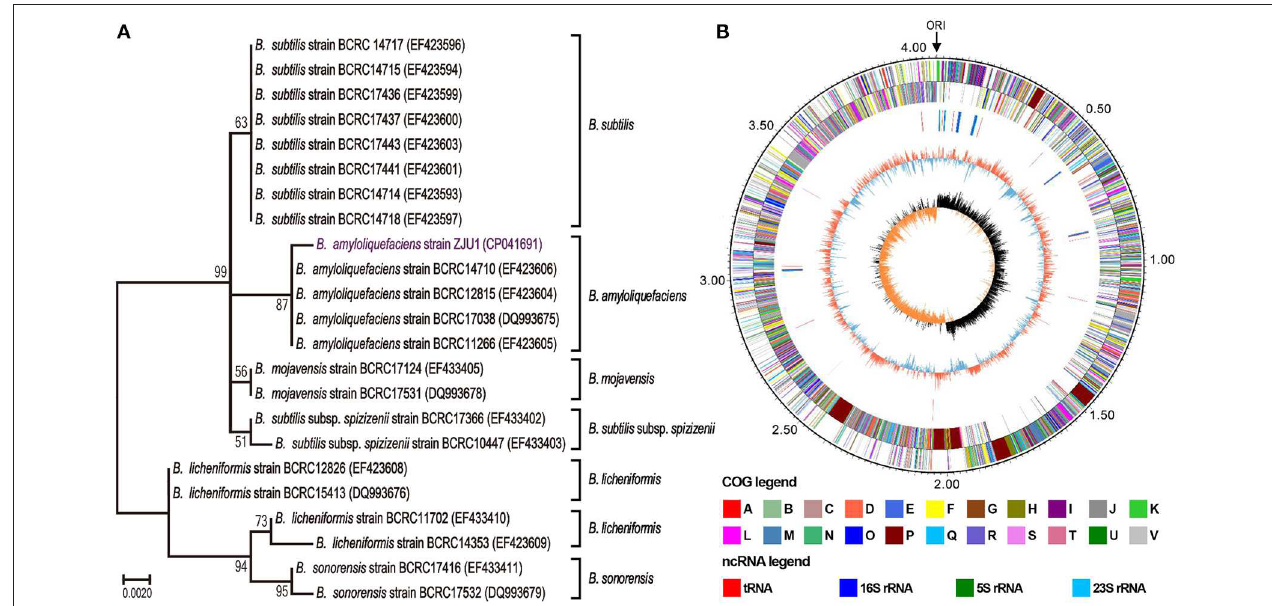
FIGURE 2 | Phylogenetic analysis and circular chromosome of strain ZJU1. (A) Phylogenetic tree of B. amyloliquefaciens ZJU1 based on the 16S rRNA gene sequences of 23 representative Bacillus strains. BCRC, the Bioresource Collection and Research Center, Japan. The tree was built using the construct/test neighbor-joining method with bootstrap test values (based on 500 replications) expressed as a percentage of 100 at the branch points. Only bootstrap percentages above 50% are shown. (B) The circular genome map revealing the genetic basis of ZJU1. From outside to inside, the map shows the (1) size of the complete genome (M); (2–3) sequences encoding the amino acids in proteins on the + and – strands, with different colors representing different COG functional classifications; (4) rRNA and tRNA; (5) GC content, where the outward red portion indicates that the GC content in this region is higher than the average GC content of the whole genome, and the inward blue portion indicates that the GC content in this region is lower than the whole genome average, where the higher the peak value, the greater the difference from the average GC content; and (6) GC skew value (G–C/G + C). When the value is positive, the CDS is more likely to be transcribed from the positive chain; otherwise, the CDS is more likely to be transcribed from the negative